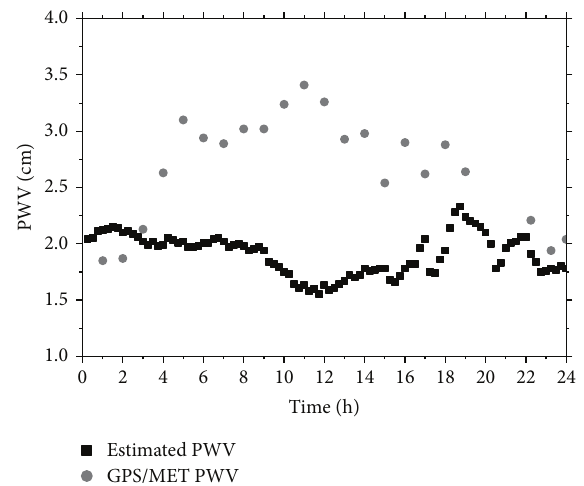
Figure 9: The 16 November 2011 case: PWV values as determined by GPS/MET (grey circle) and estimated from surface temperature and humidity (black